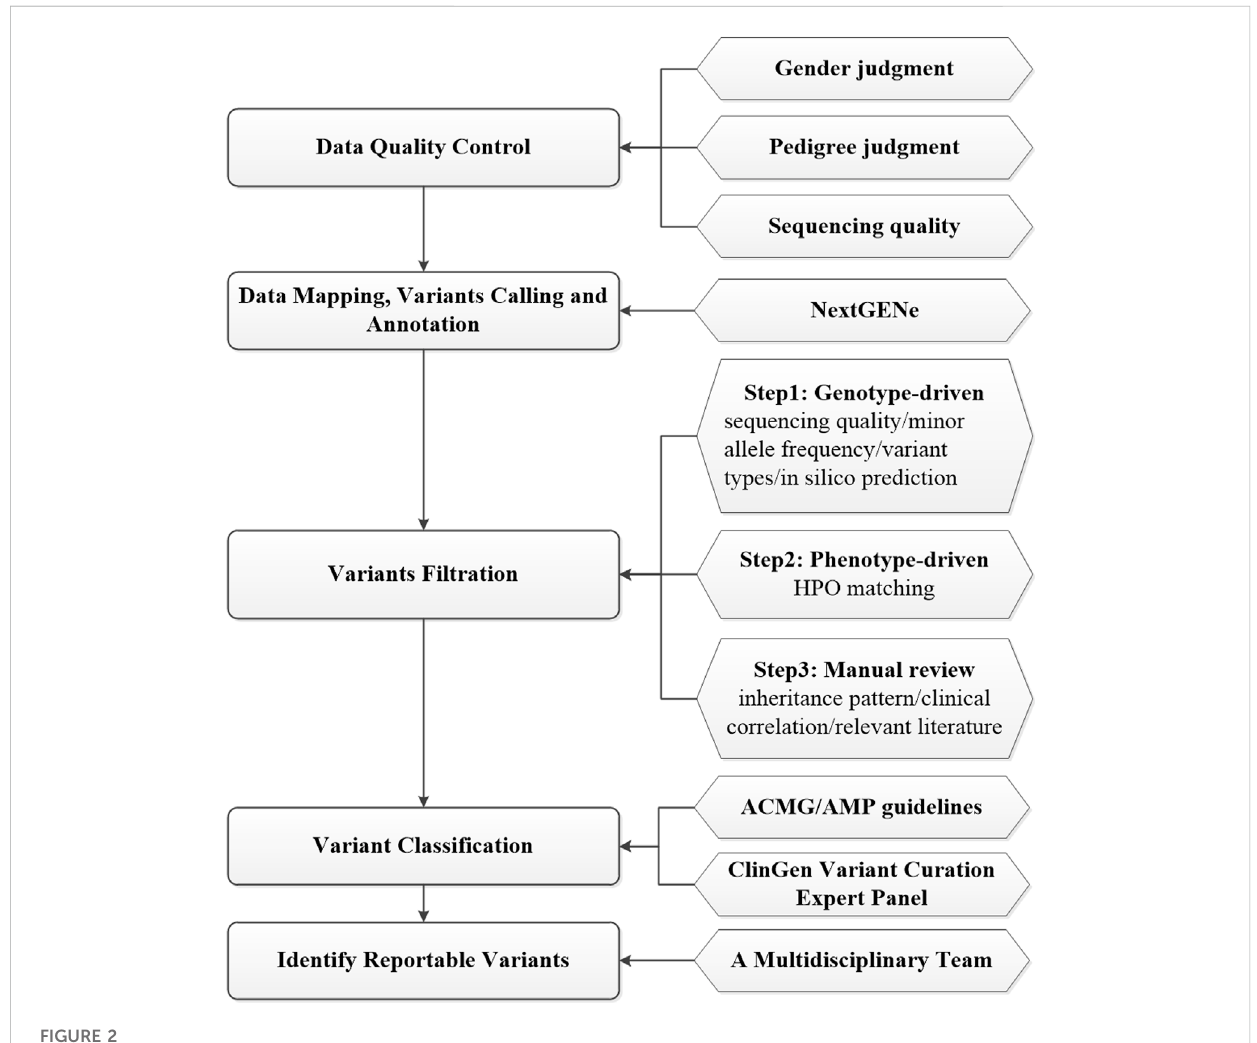
FIGURE 2 Data analysis process of exome